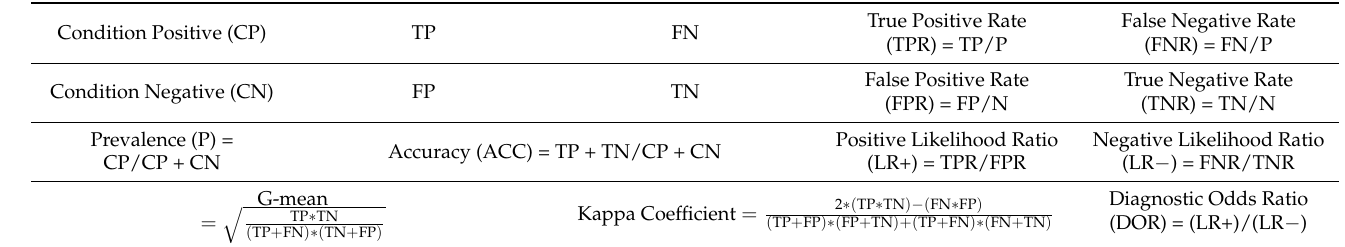
Table 4. Details of the Confusion Matrix and Formulas of FoM